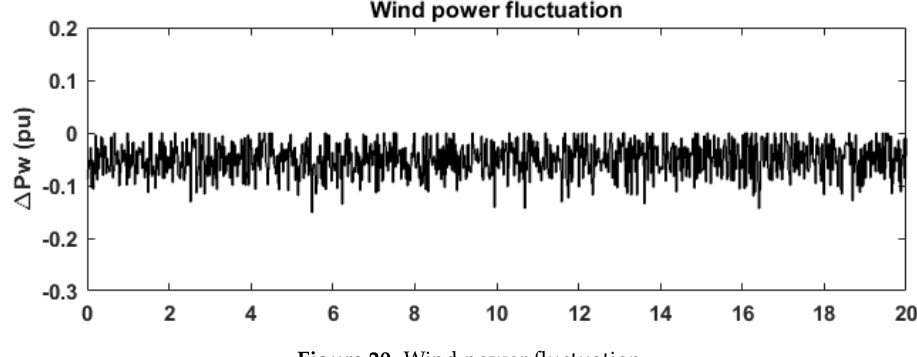
Figure 20. Wind power fluctuation.